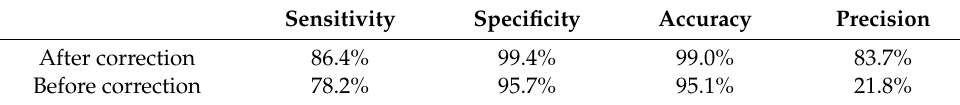
Table 3. Evaluation metrics before and after automated corrections.